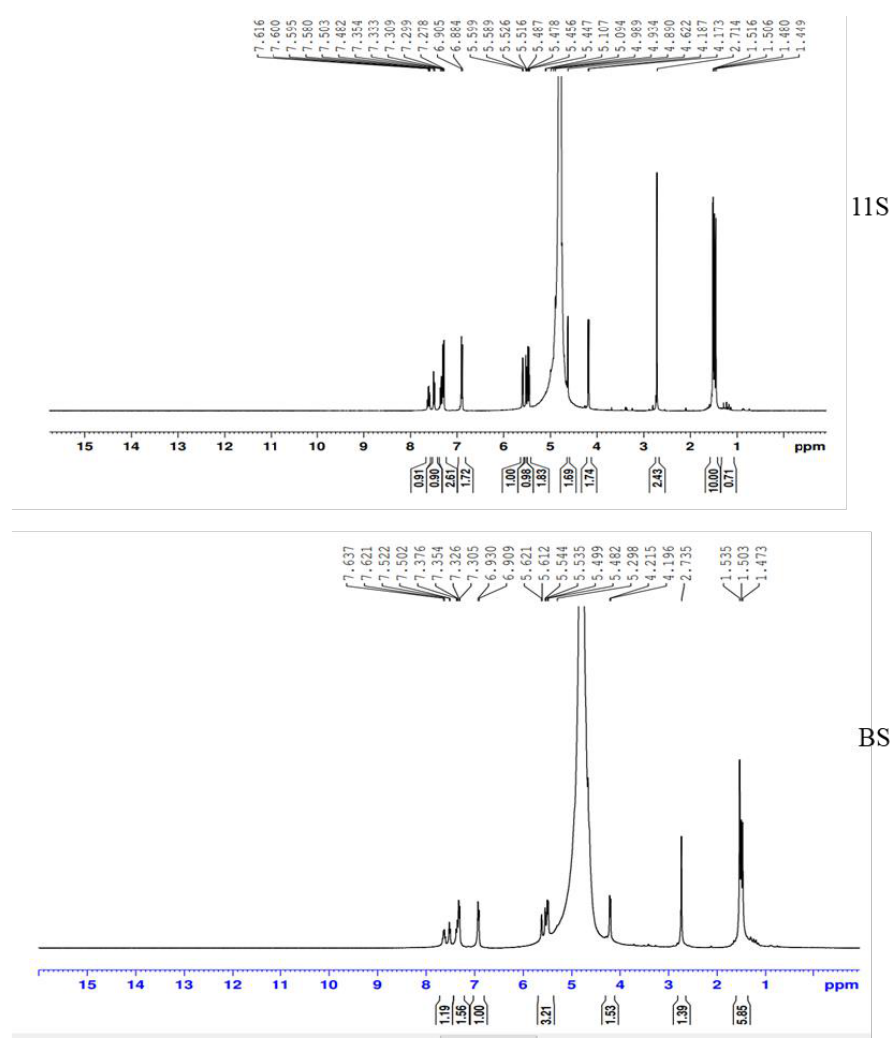
Figure 4. 1 H NMR spectra of 11S globulin and BS.